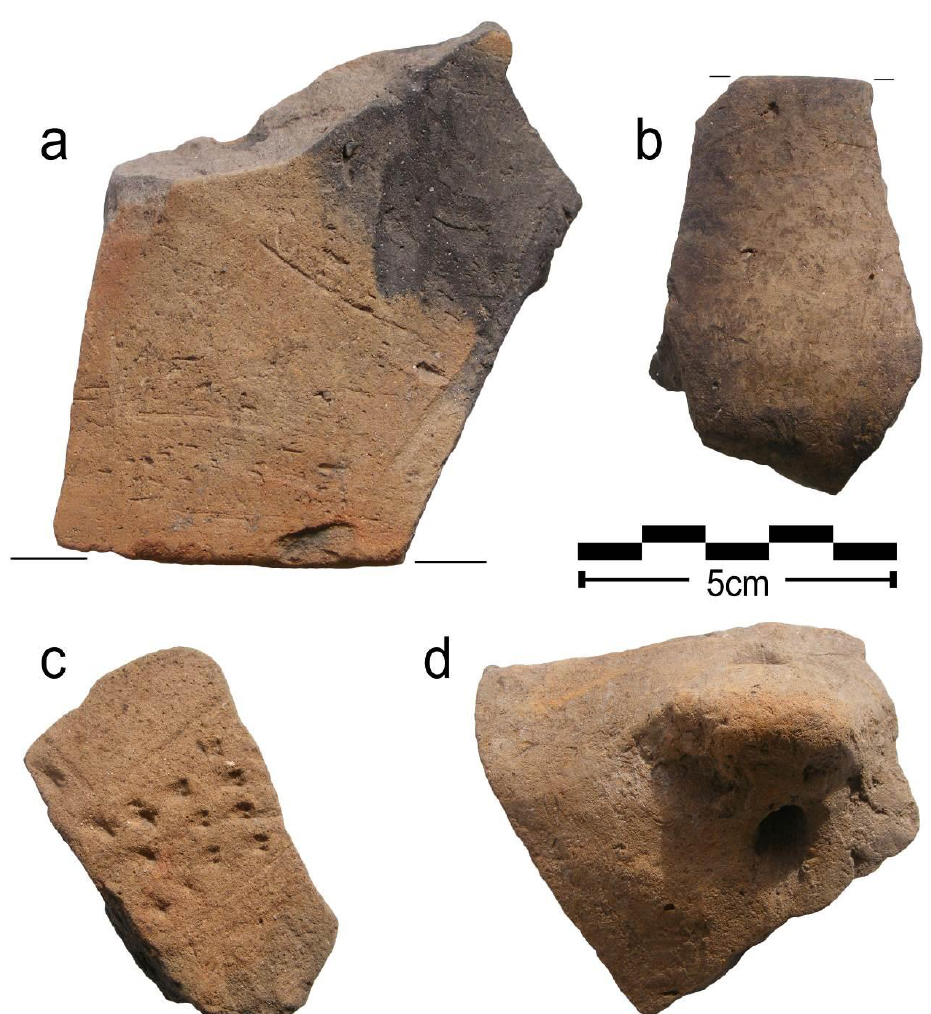
Figure 6. Petrești (a) and Vinča (b-d) culture pottery discovered at the Răcătău-Piatra Tomii